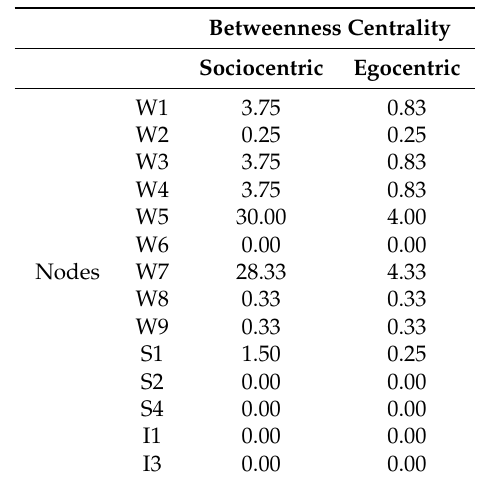
Table 1. Egocentric and sociocentric betweenness scores of Figure